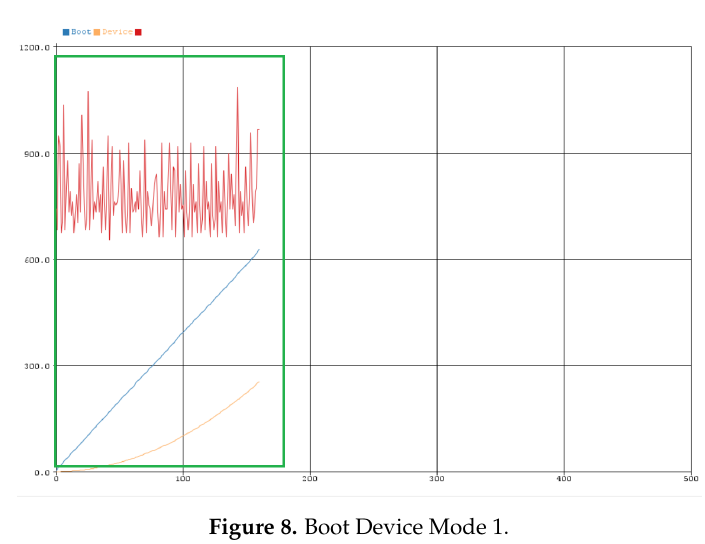
Figure 7. Measurements by applying the second software filter.